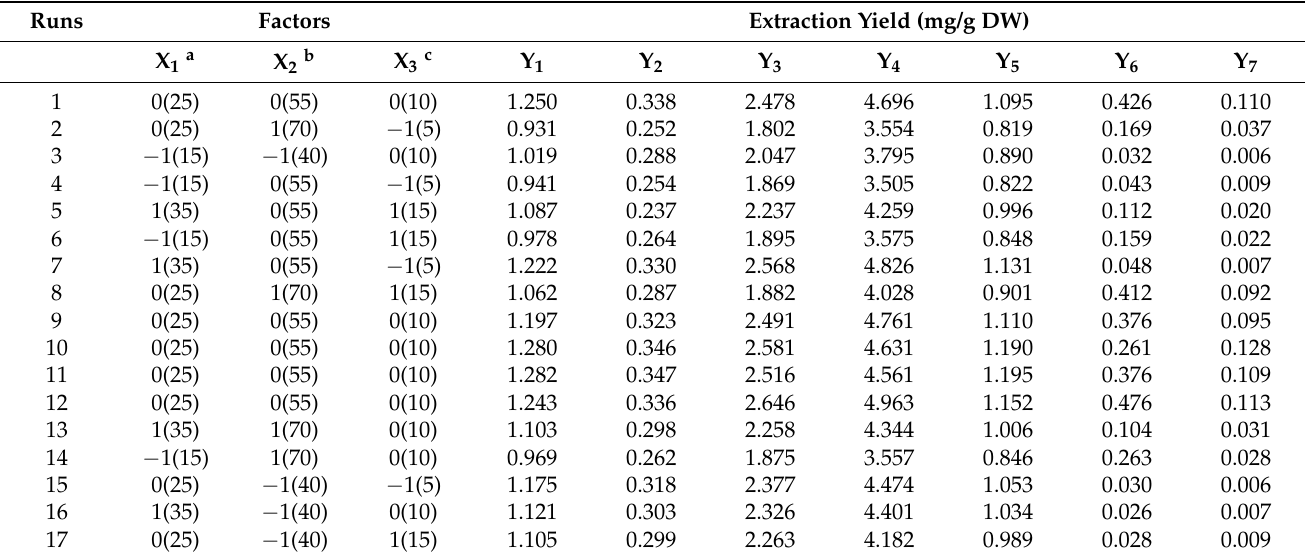
Table 2. Experimental values of Box–Behnken design (BBD) for the extraction of rutin, hyperoside, isoquercetin, trifolin, astragalin, quercetin, and